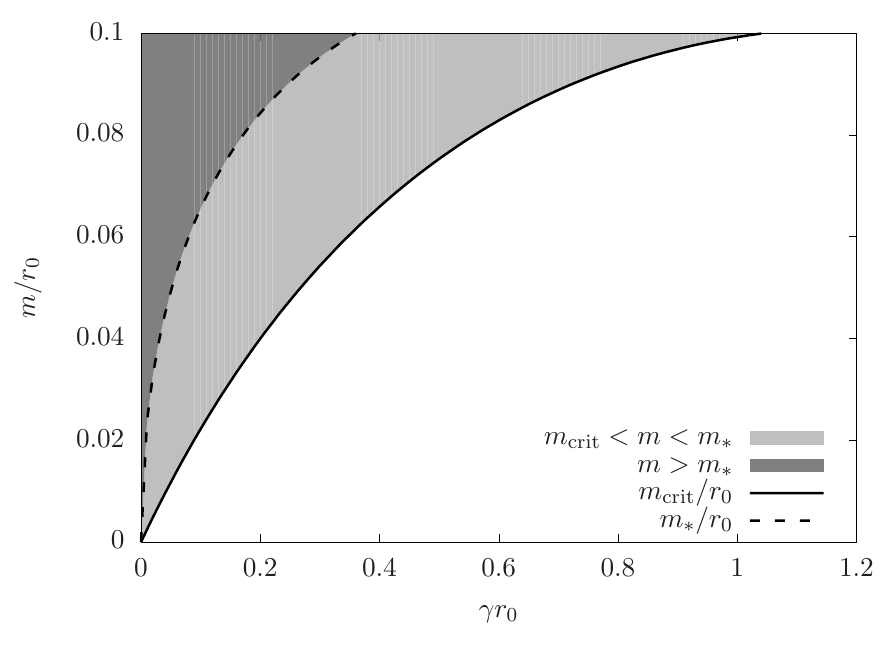
Figure 3. Plot of m / r 0 vs. γ r 0 , where k = 0. The shaded regions shows the range m crit < m < m gives reduced deflection, while the darker-shaded regions correspond to m > m